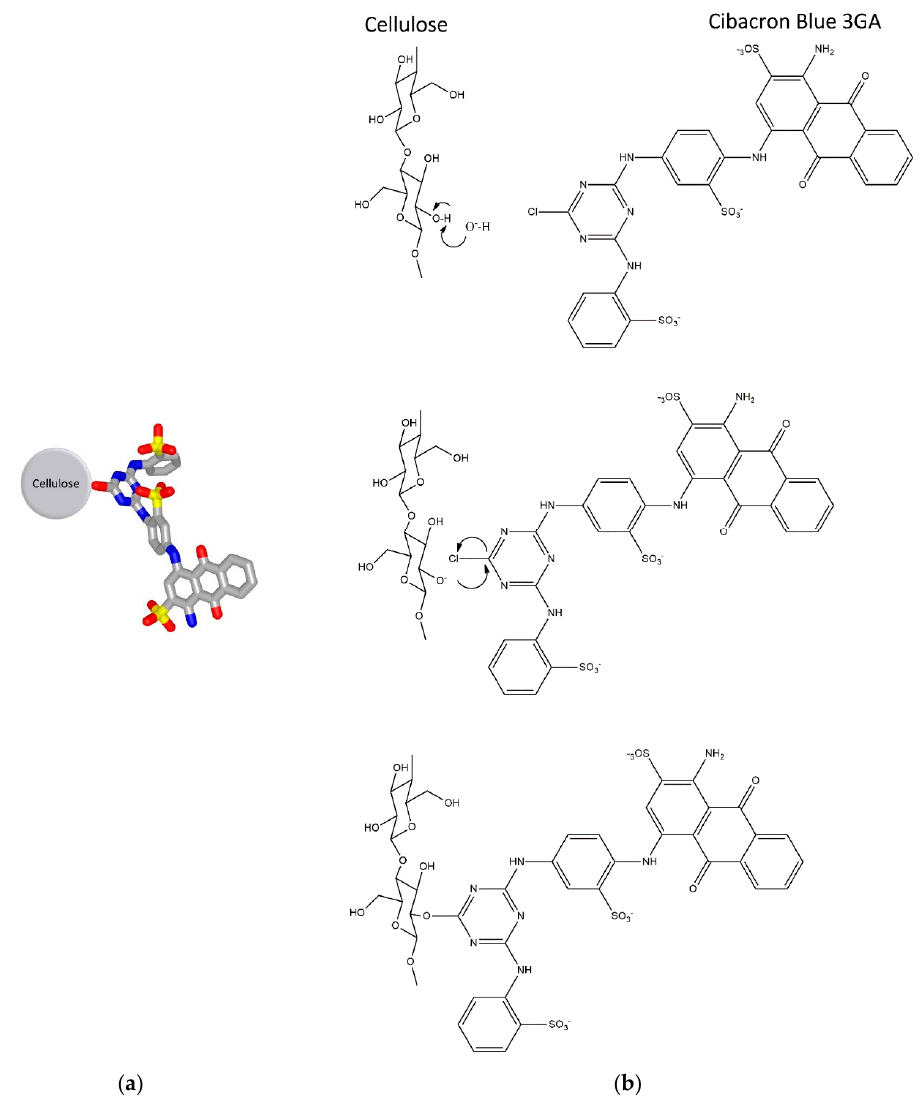
Figure 2. ( a ) The putative structure of the affinity adsorbent. The immobilized ligand is the triazine dye CB3GA. ( b ) The synthetic route for the synthesis of the affinity adsorbent. The structures were created by ChemDraw Ultra 12.0.